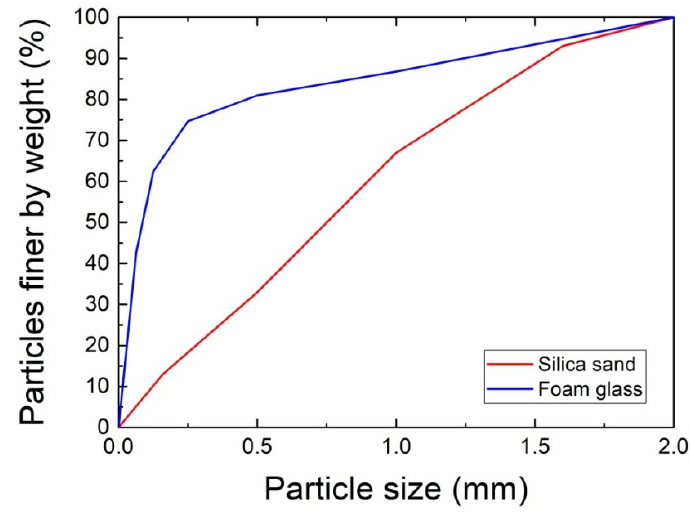
Figure 2. Particle size distribution curves of quartz sand and foam glass.